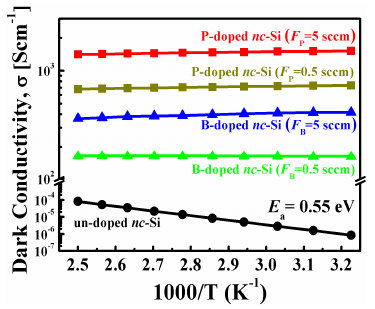
Figure 4. Temperature-dependent conductivities of nc-Si films with and without doping.